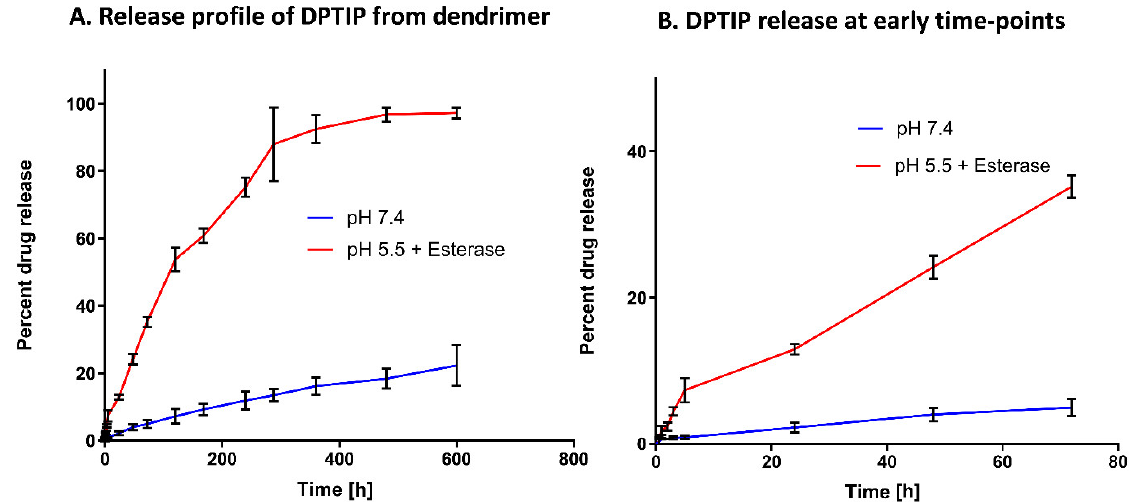
Figure 3. In vitro drug release profile of the D-DPTIP conjugate. ( A ) DPTIP shows a sustained release behavior at intracellular pH with >90% release in 2 weeks and only ~20% release at pH 7.4 in ~21 days. ( B ) The drug release profile at the early time points showing ~10% release in 24 h at intracellular conditions with a negligible DPTIP release at pH 7.4.